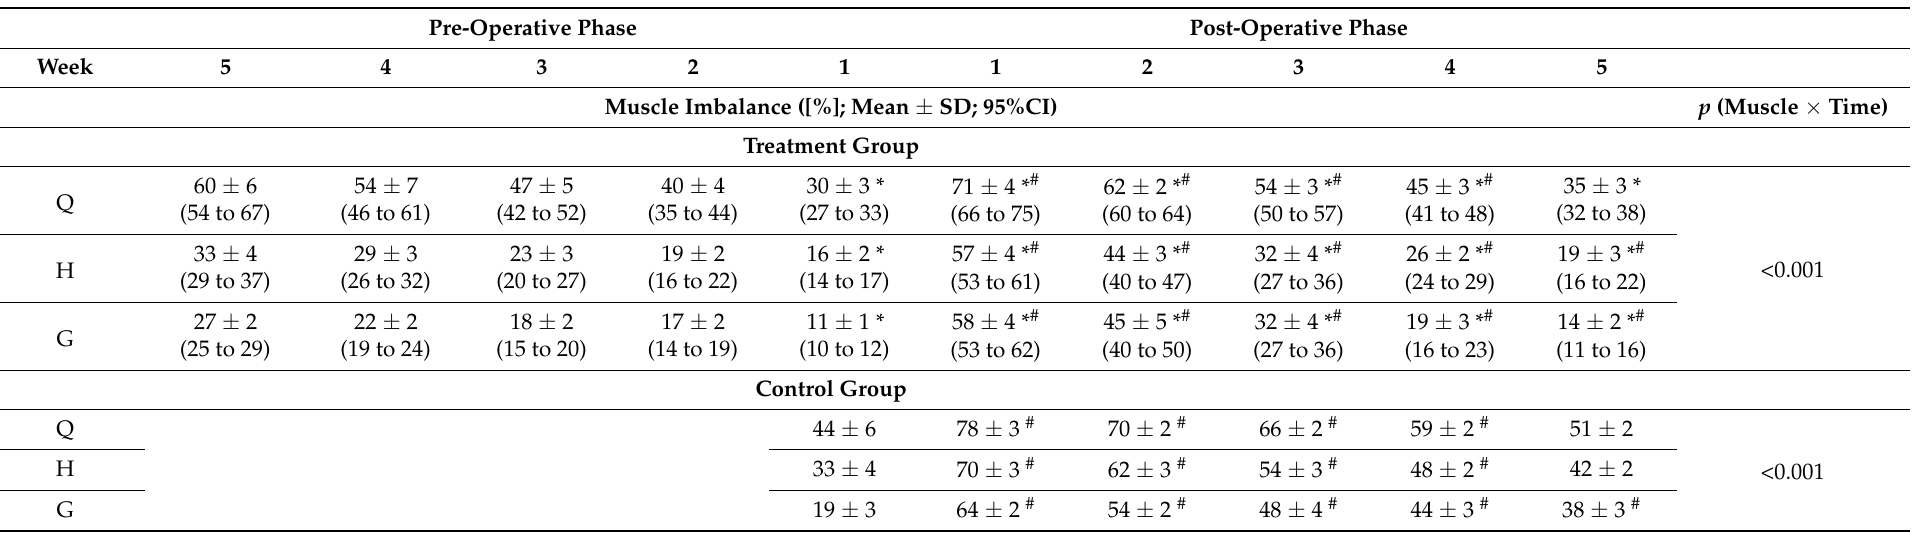
Q—Quadriceps muscles, H—hamstring muscles, G—gluteal muscles; SD—standard deviation, CI—confidence interval; * significant difference between treatment and control group in corresponding week <0.05; # significant difference in comparison to the last week before surgery within group